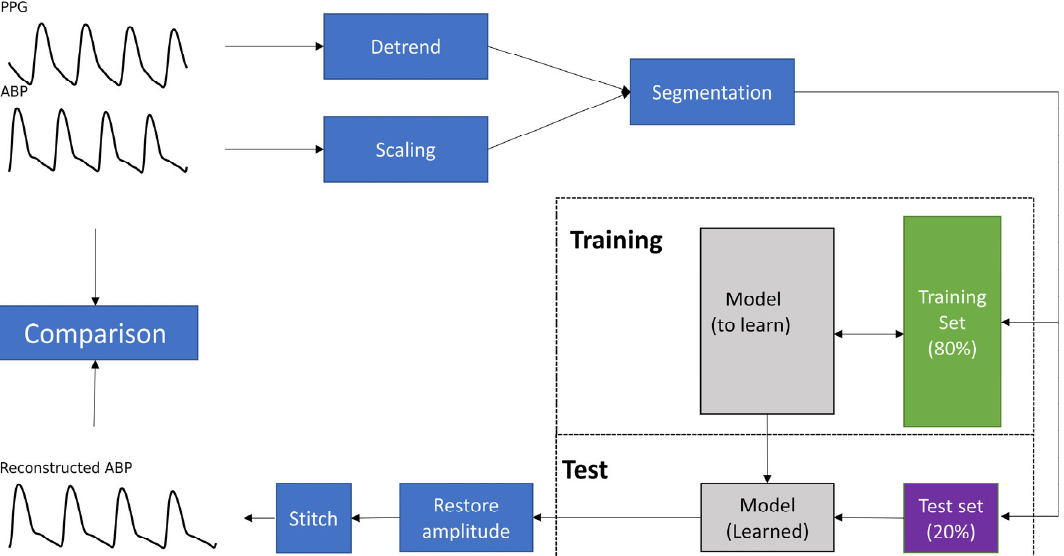
Figure 2. Flowchart of the proposed method. For each record, the PPG was detrended, and the ABP was scaled in preprocessing. Then, they were segmented into 8.2 s. The first 80% of segments were used for training, and the last 20% were used for testing. For the test set, the ABP signal of the segments was stitched to generate the reference ABP. In addition, the model’s outputs were stitched to generate the reconstructed ABP. Note that PPG = Photoplethysmogram and ABP = Arterial blood